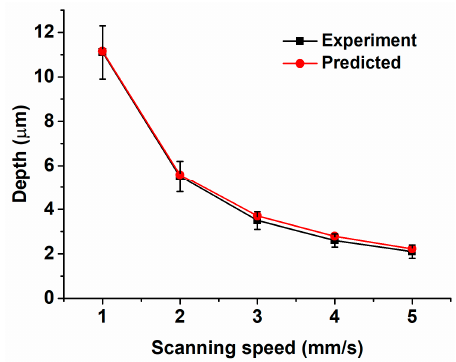
Figure 5. Effect of scanning speed on machined depth of micro-channels.